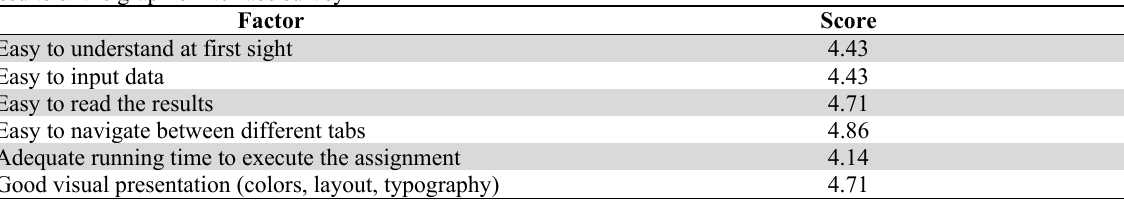
Results of the graphic interface